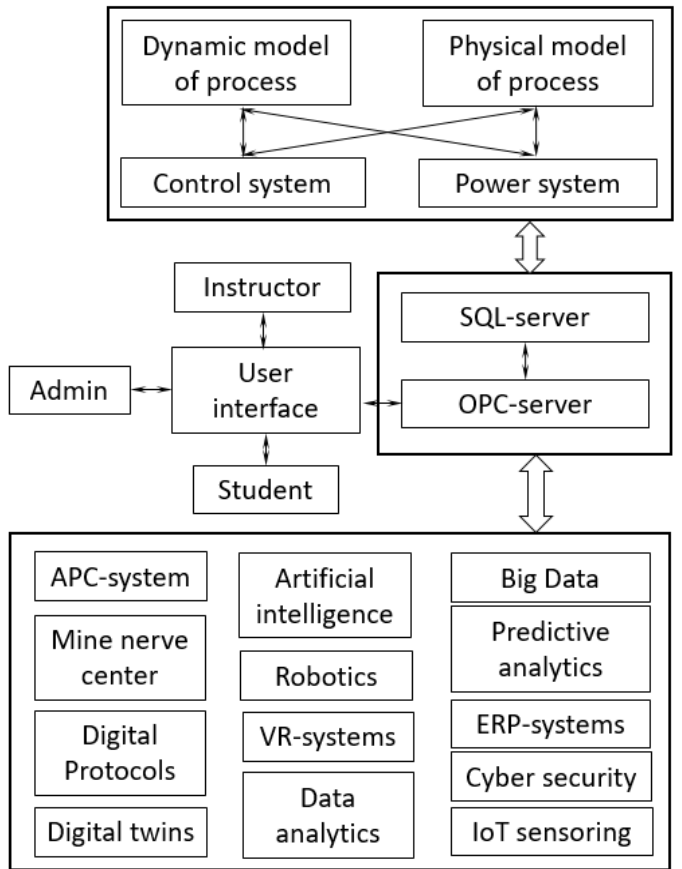
Figure 1. Diagram of the computer simulator under development.